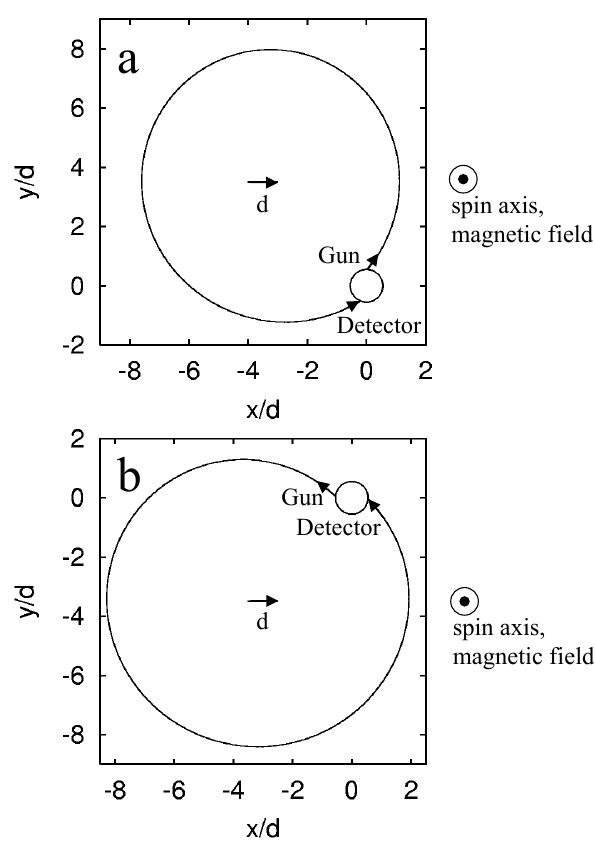
Fig. 1. Configuration of an electron gun and detector attached to the main body of the satellite. The orbits of electron beams are depicted for a simple case when the magnetic field is parallel to the spin axis. In the example shown, B 0 = 10 4 nT and the drift step vector d = 2 m in the + Y direction for a cyclotron period. Return beams are detected for the two spin phases, as shown in a and b.